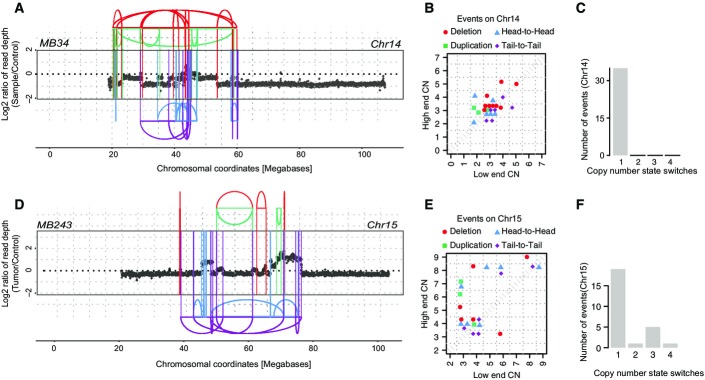
Evidence for hyperploidy being a risk factor for chromothripsis in SHH-type medulloblastoma
Oscillating copy number states and SRs on chromosome 14 in MB34 (based on WGS data), resulting from chromothripsis. SRs are color-coded: red, deletion type (T-H); green, duplication type (H-T); blue, head-to-head (H-H) type; purple, tail-to-tail (T-T) type; gray, inter-chromosomal.

Copy number jump distribution for chromosome 14 in MB34, with diagonal points indicating chromothripsis occurred on a previously unrearranged chromosome.

Distribution of copy number segment switches for chromosome 14 in MB34.

Oscillating copy number states and SRs on chromosome 15 in MB243 (based on WGS data), resulting from chromothripsis and BFBs.

Copy number jump distribution for chromosome 15 in MB243, with off-diagonal points indicating chromothripsis occurred on a previously rearranged chromosome.

Distribution of copy number segment switches for chromosome 15 in MB243.